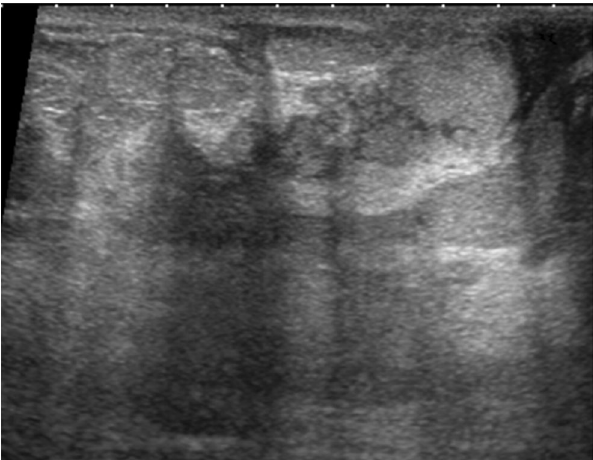
Fig. 10 Abscess. A 42-year-old woman presenting with enlargement of the left breastfor 1monthwith painanderythema relatedtomastitisofthe